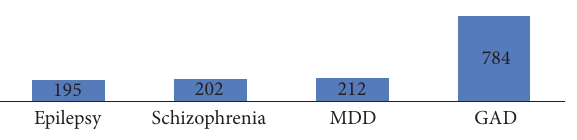
Figure 3: Distribution of respondents’ perception regarding possi- bility of treatment of mental illness ( 𝑛 = 816 ), Gimbi town,